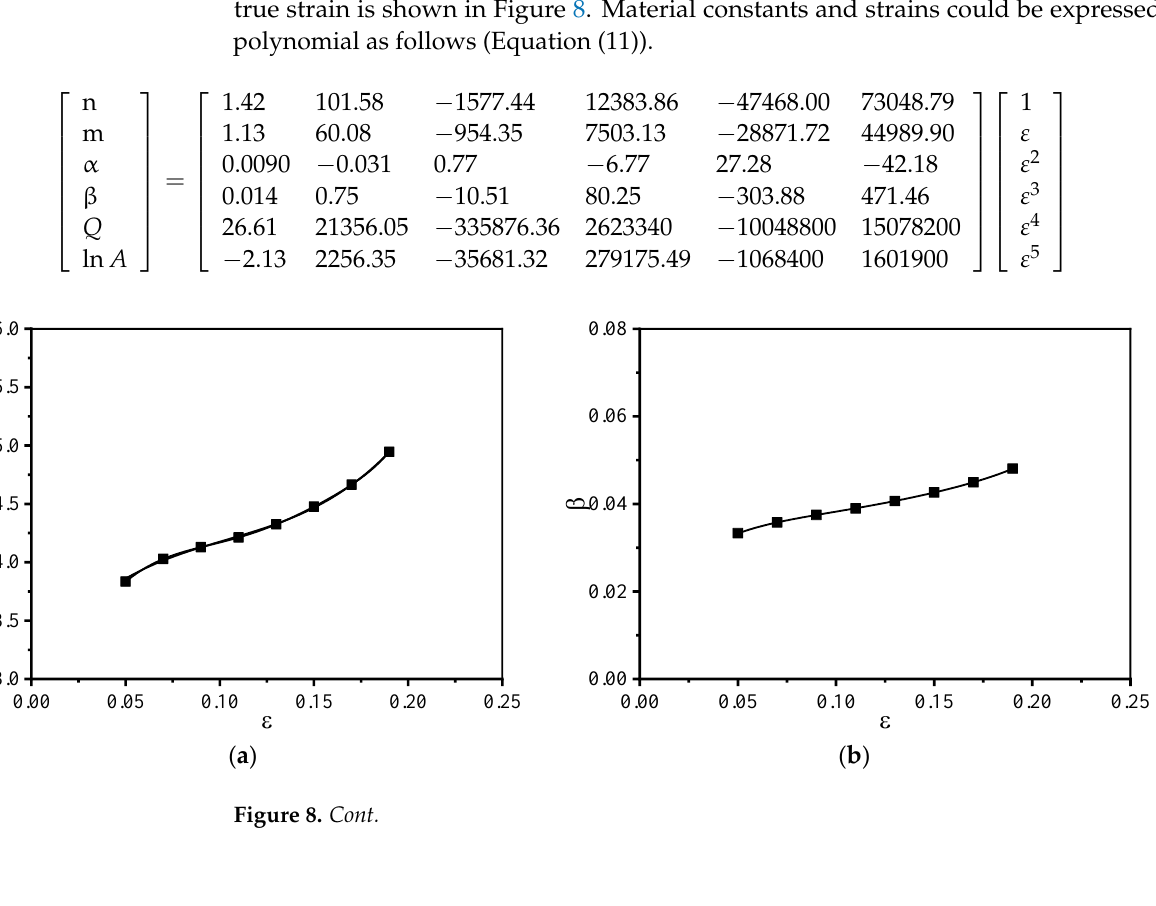
Figure 7. Relationship between stress and strain rate and temperature: ( a ) ln [ sinh ( ασ )] − ln ; ( b ) ln [ sinh ( α σ )] − 1/ T .